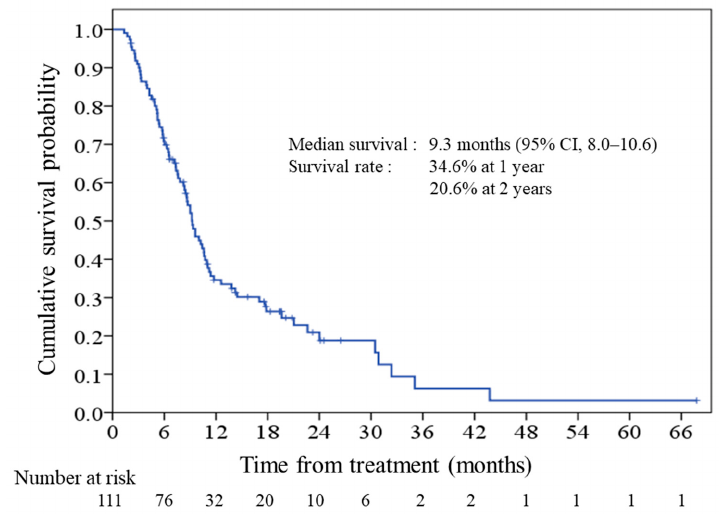
Figure 1. Kaplan-Meier plot of overall survival in patients with advanced pancreatic cancer treated with gemcitabine plus S-1. CI, confidence interval. Table 2. Univariate and multivariate analyses for overall survival. Univariate Analysis Variable Category